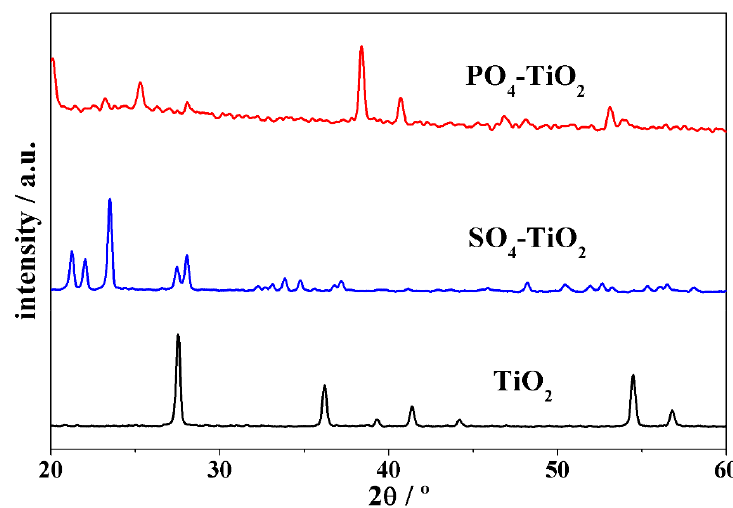
2 , PO 4 -TiO 2, and SO 4 -TiO 2 .